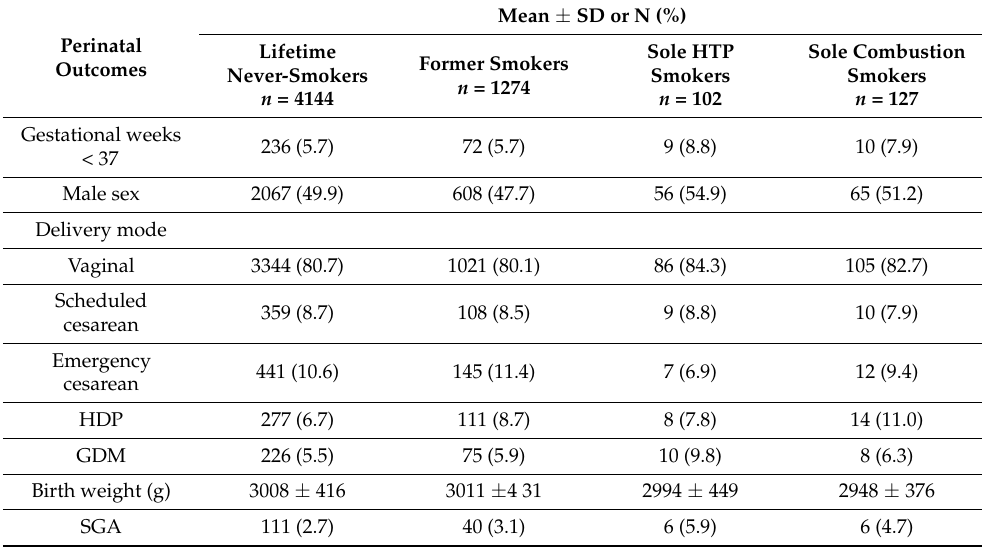
Table 1. Perinatal outcomes across smoking categories among 5647 post-delivery women with singleton pregnancy.